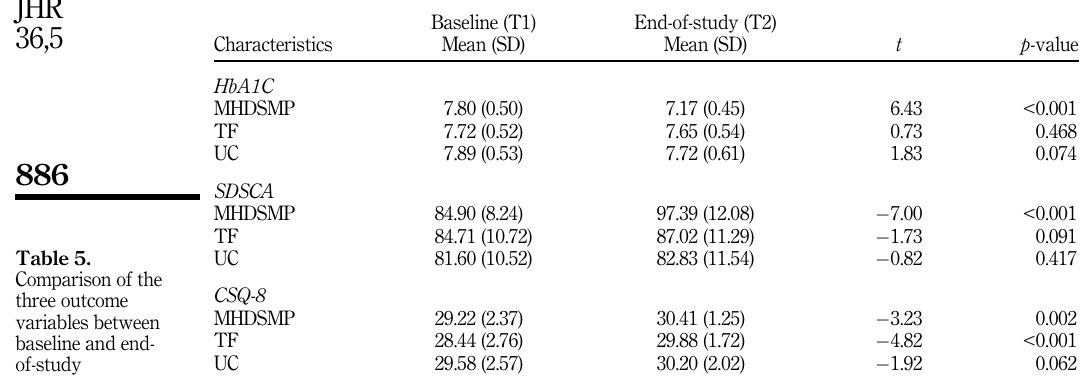
Table 5. Comparison of the three outcome variables between baseline and end-